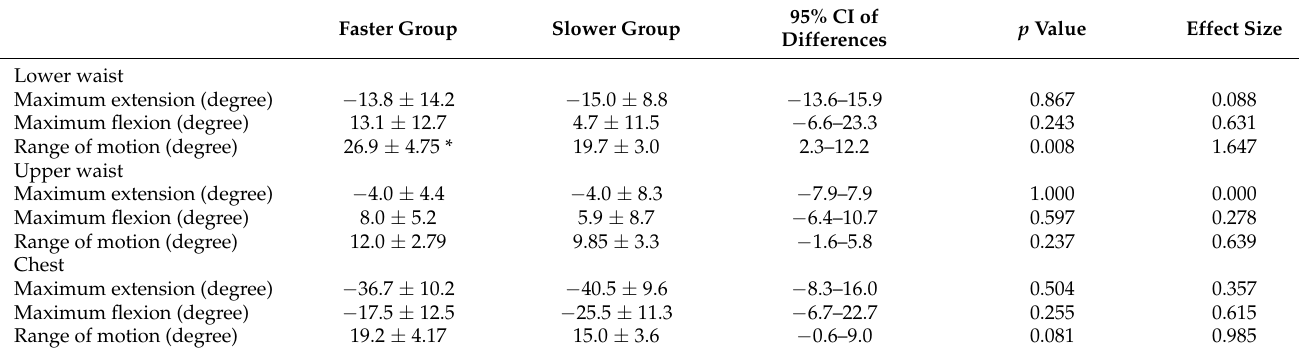
Table 3. The maximum extension and flexion angle and range of motion of the lower waist, upper waist, and chest.